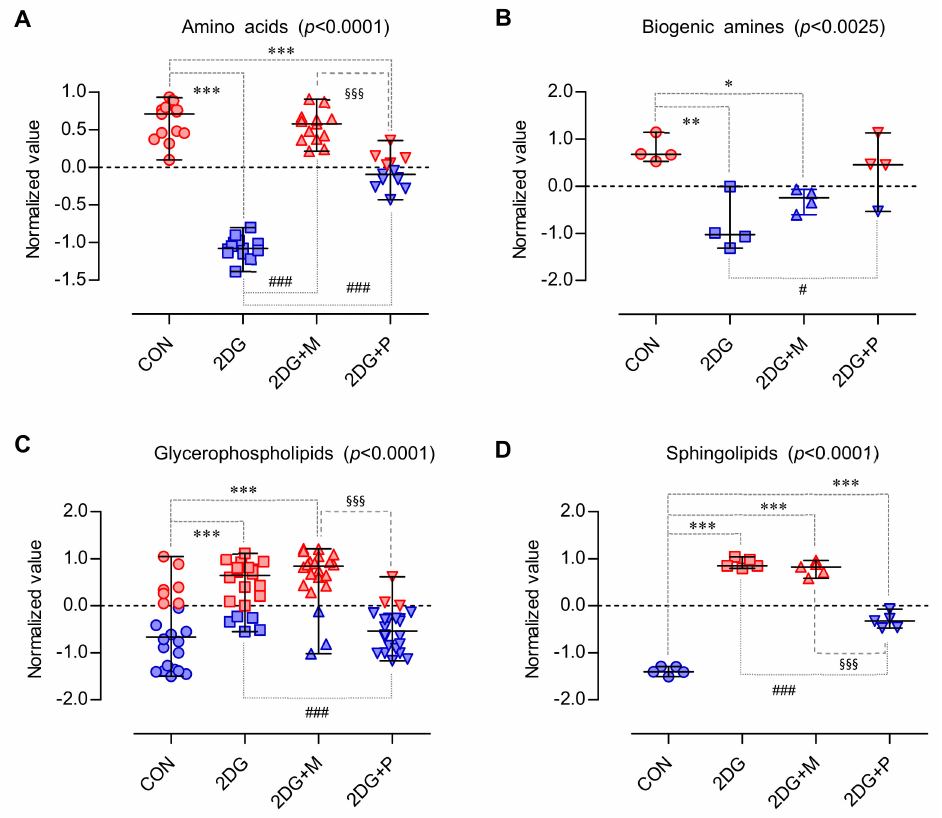
Figure 6. Scattered dot plot of the normalized values of the metabolites. The normalized values > 0 is marked in red and those < 0 in blue. ( A ) Amino acids ( B ) Biogenic amines ( C ) Glycerophospholipids ( D ) Sphingolipids; Scatter dot plot (median with range); One-way ANOVA with Tukey’s multiple comparison test; ***: p < 0.001, **: p < 0.01, *: p < 0.05 (vs CON); ###: p < 0.001, #: p < 0.05 (vs 2DG); §§§: p < 0.001 (vs 2DG +